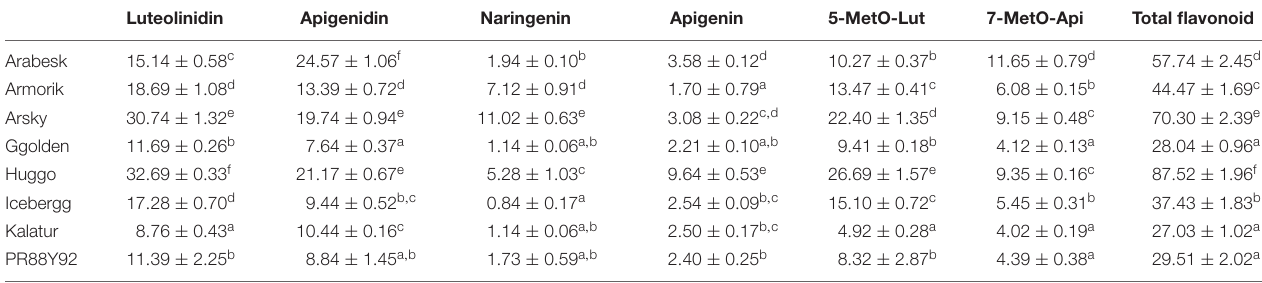
TABLE 6 | The content of flavonoids in the eight varieties of sorghum was calculated from the peak areas of the HPLC chromatograms. Luteolinidin Apigenidin Naringenin